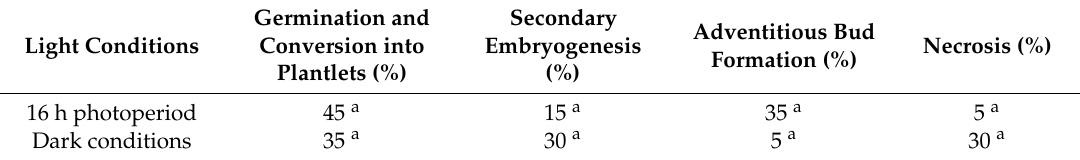
Table 3. E ff ect of light conditions on somatic embryo germination and conversion into plantlets. Secondary Germination and Adventitious Bud Necrosis (%) Embryogenesis Light Conditions Conversion into Formation (%) (%) Plantlets (%) 16 h photoperiod 45 a 15 a 35 a 5 a Dark conditions 35 a 30 a 5 a 30 a Means in the same column followed by di ff erent letters are significantly di ff erent.